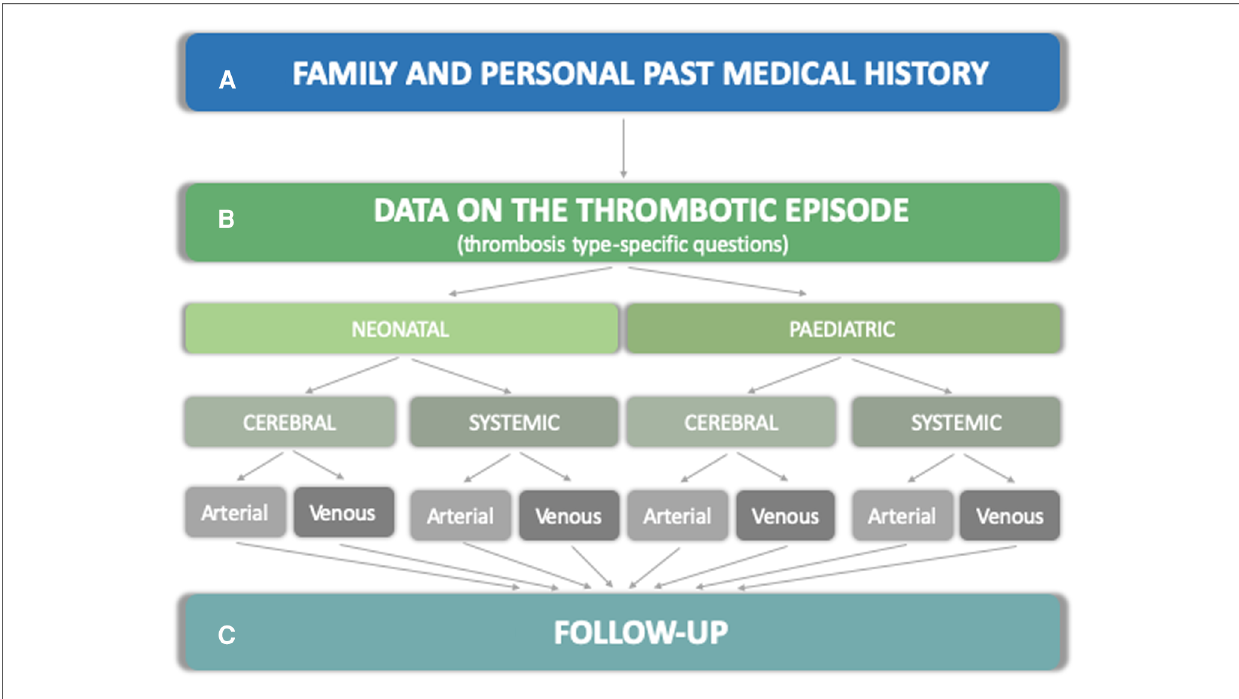
FIGURE 1 Structure of the data collection form in the RITI registry. The structure of the registry is articulated into sections A (family and past medical history) B (thrombosis-speci fi c questions on risk factors, clinical and radiological presentation, investigations, treatment, clinical and radiological outcome) and C (follow-up